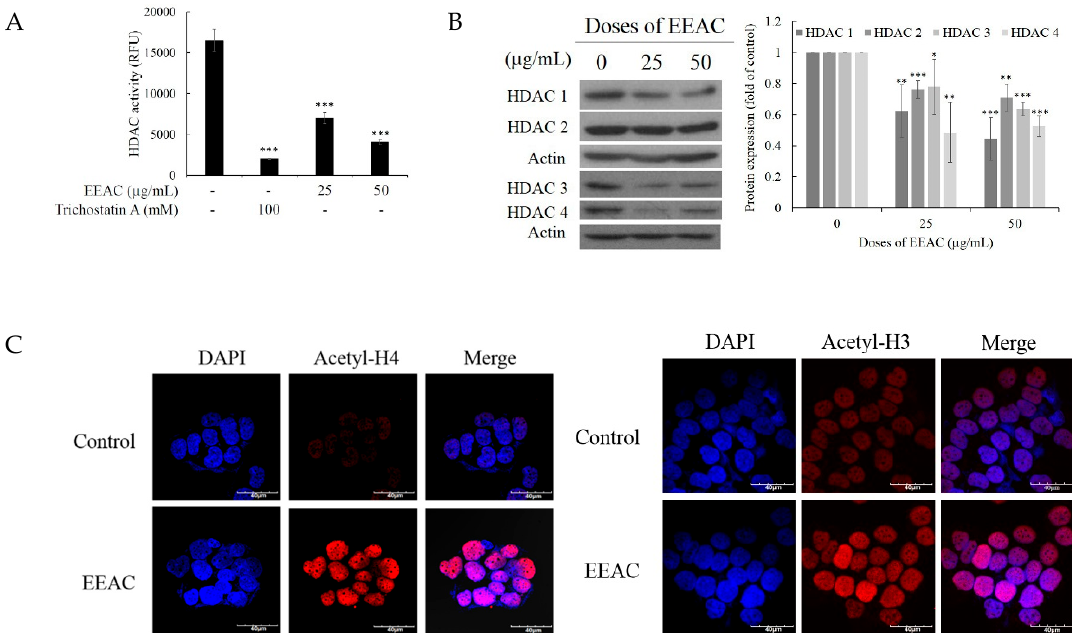
Figure 4. Effect of EEAC on histone deacetylase activity. ( A ) The effect of EEAC on HDAC mediated deacetylation in the cell-free system. ( B ) T47D cells were treated with EEAC (25 and 50 µ g/mL) for 48 h and the expression of HDACs 1, 2, 3, and 4 was determined by Western blot assay. Actin was used as the loading control. ( C ) Confocal microscopy image of acetyl-H3 and acetyl-H4 stained T47D cells treated with EEAC (50 µ g/mL) for 48 h. Cells were counterstained with DAPI to label cells nuclei (blue). All the results are presented as mean ± SD of at least three experiments, * p < 0.05; ** p < 0.01; *** p < 0.001.